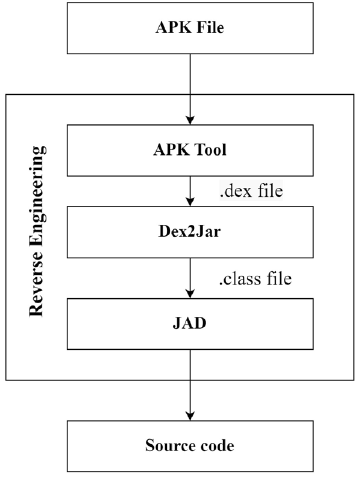
Figure 1. Android application package (APK) reverse